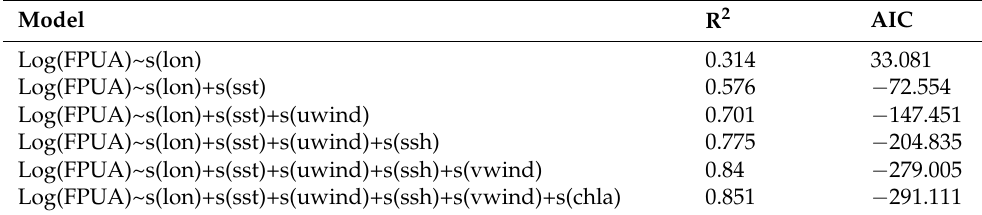
Table 3. Statistical characteristics of the